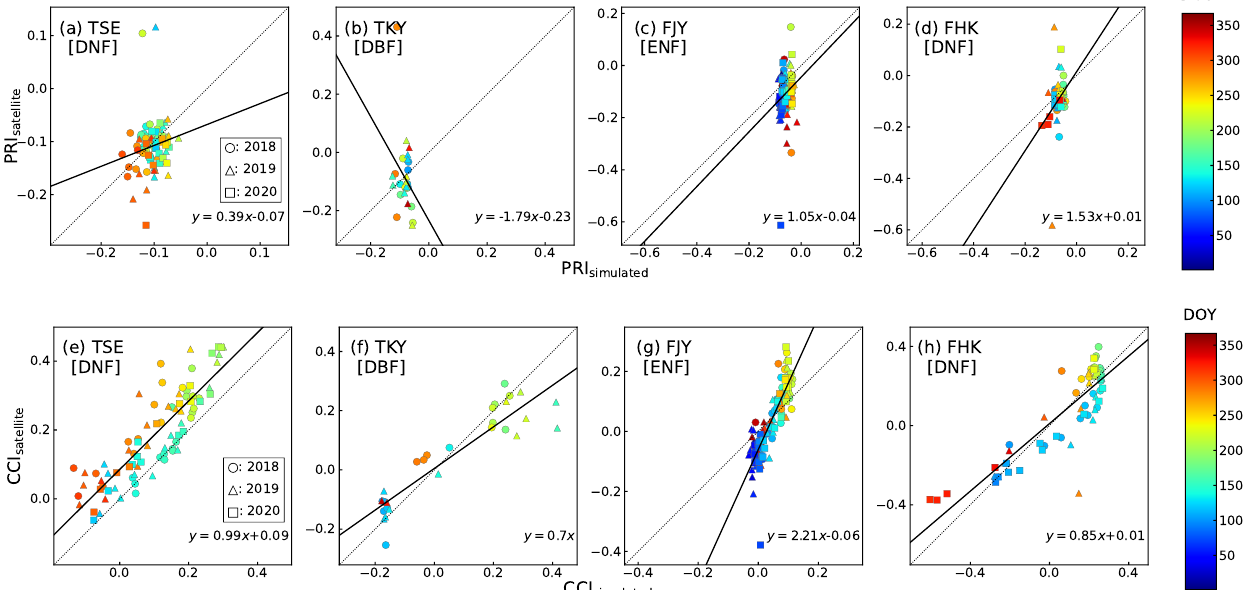
0.2 CCI simulated Figure 11. Scatter plots of snow-free PRI ( a – d ) and snow-free CCI ( e – h ). Satellite data were screened with the QA flag (QA = 2). Additionally, satellite data observed in snow seasons were manually removed. The dotted line represents the 1 : 1 line. The black solid line is the linear regression line. The shape of each point represents the year. The color of each point corresponds to the DOY. Table 8. The statistics of the accuracy assessment for snow-free PRI satellite and snow-free CCI satellite . Site